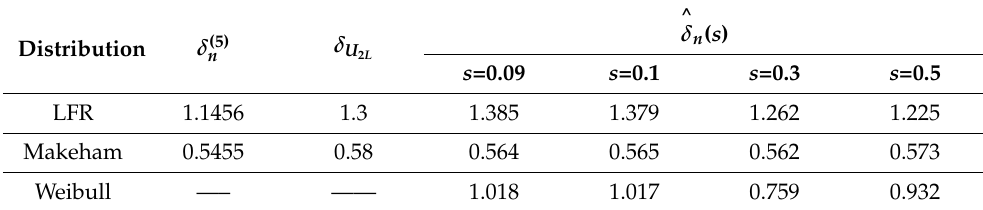
( 1 ) n , δ U 2 L and